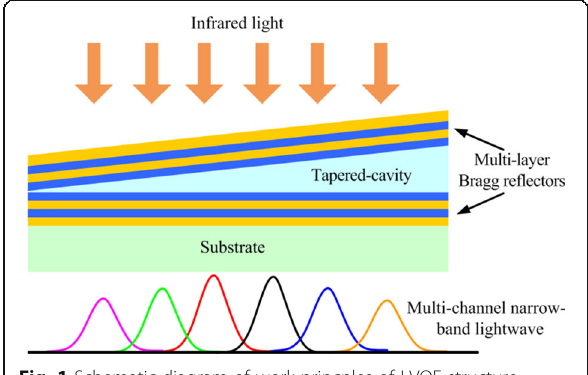
Fig. 1 Schematic diagram of work princples of LVOF